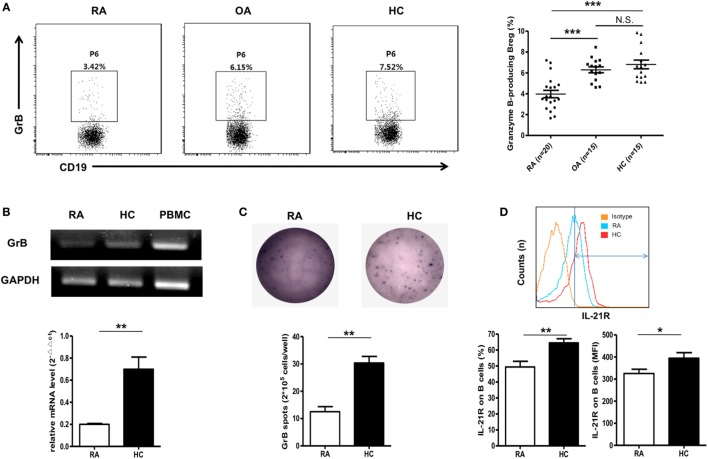
Reduction of GrB-producing regulatory B cell (Breg) in rheumatoid arthritis (RA) patients. (A) The frequencies of GrB-producing Breg were assayed by FACS in RA patients (n = 20), osteoarthritis (OA) patients (n = 15), and healthy donors (n = 15) as in Figure 1A. The representative flowcharts (left) and statistical results were showed (right) (one-way ANOVA with post hoc Dunnett’s t test). (B) Purified CD19+ B cells by FACS from five RA patients and five healthy controls were subjected to detection of mRNA expression of GrB by PCR (upper) and Q-PCR (bottom). (C) B cells from four RA patients and four healthy controls were cultured with CpG stimulation (10 µg/ml) on ELISpot plates at the density of 2.5 × 105 cells/well for 24 h. Plates were developed, and GrB-secreting cells were counted. The representative photos (upper) and statistical results (bottom) were shown. (D) The frequencies and median fluorescent intensity of IL-21 receptor (IL-21R) on B cells were assayed by FACS in RA patients (n = 15) and healthy donors (n = 20). The represent flowcharts and statistical results were shown. *P < 0.05, **P < 0.01, ***P < 0.001, N.S., no significance, by Mann–Whitney test. GrB, granzyme B.